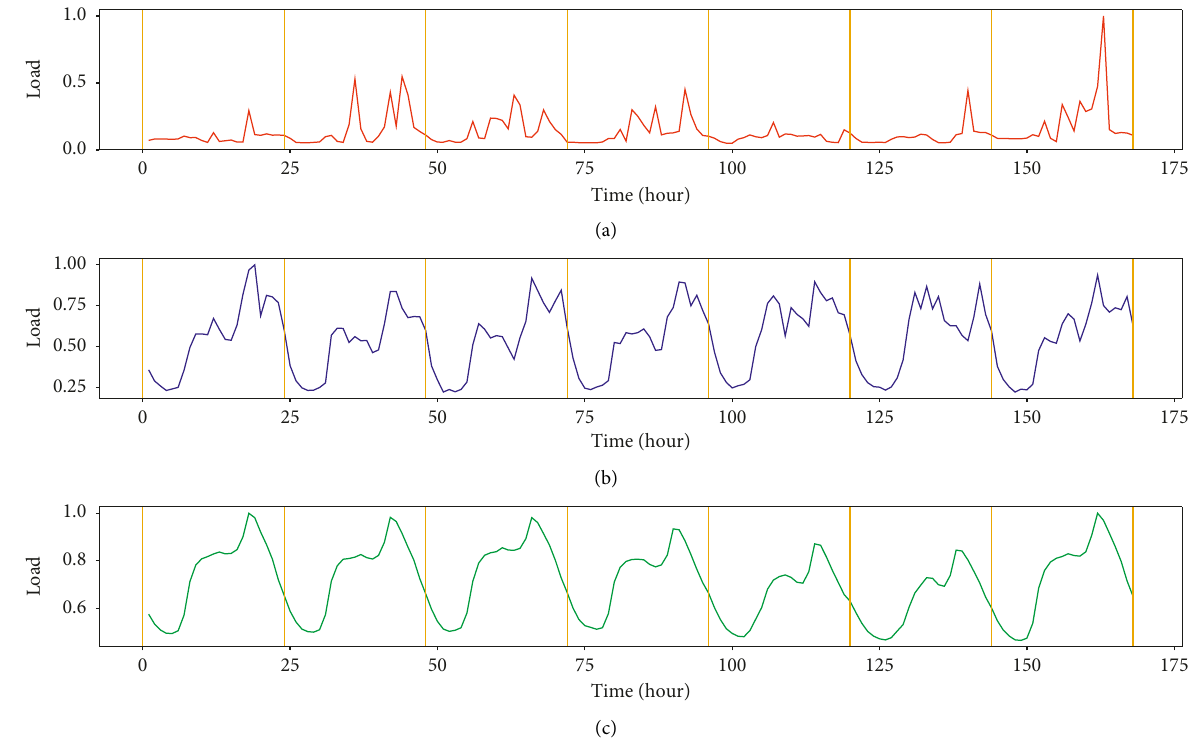
Figure 1: Three normalized hourly profiles of different level loads including (a) residential level, (b) feeder level, and (c) system